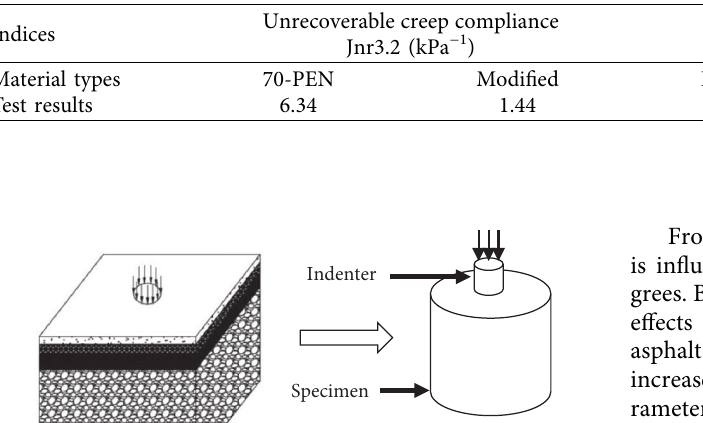
Table 3: Values of variables required for modeling (II).